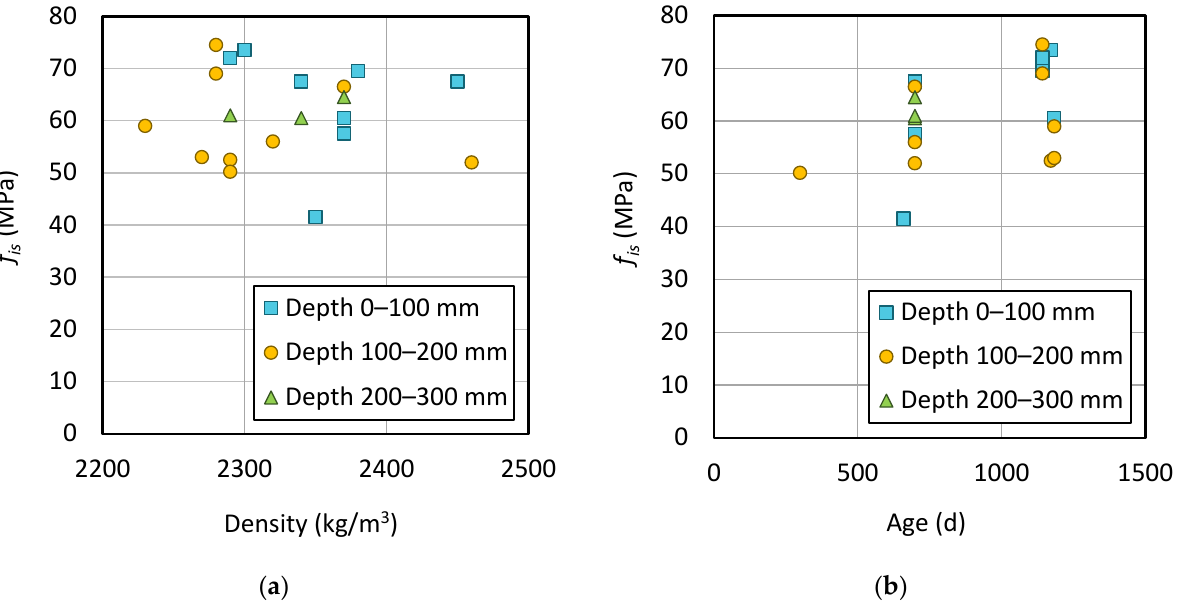
Figure 12. Relation between the crack index and time required for the casting of concrete.